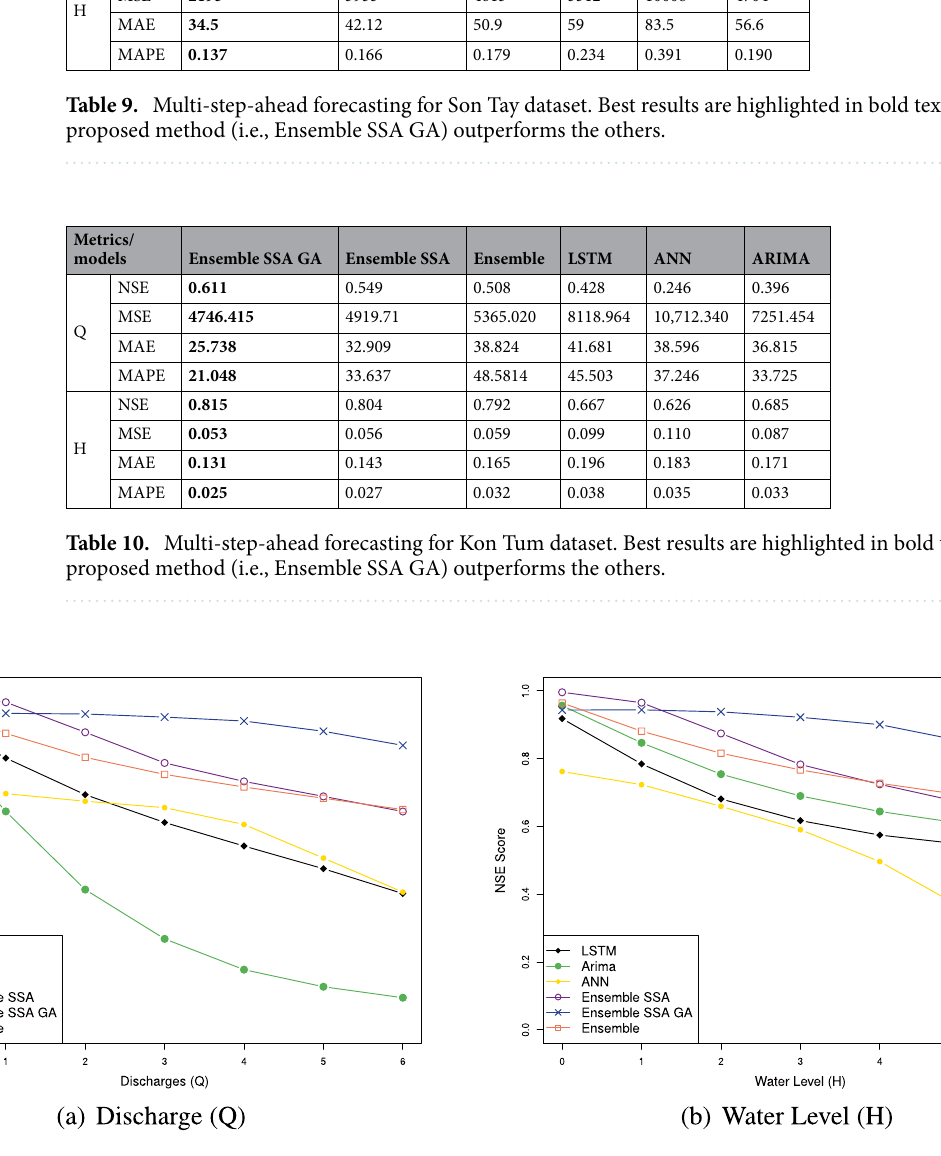
Figure 14. Multi-step-prediction NSE scores of all approaches. The NSE decreases when increasing the number of output timesteps. Overall, our proposed method achieves the highest NSE